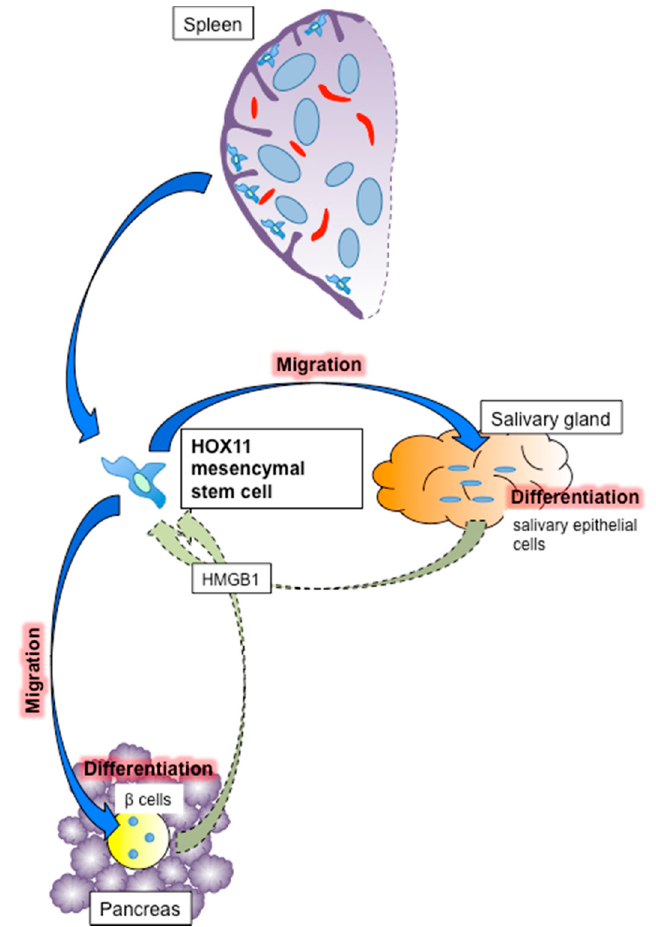
Figure 3. Mechanism of tissue repair by splenic mesenchymal stem cells. Splenic mesenchymal stem cells are normally located under the splenic capsule and migrate to the damaged tissue following stimulation by HMGB1. They then differentiate into tissue components such as β cells in pancreatic islets and salivary epithelial cells in salivary glands. HOX11-positive cells are considered to be splenic mesenchymal stem cells.